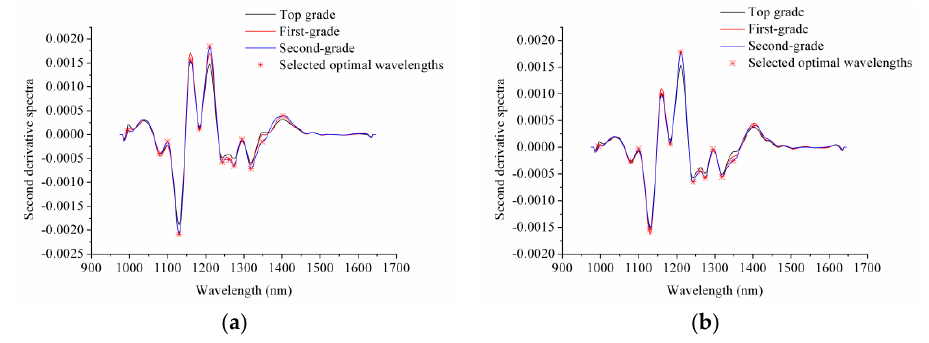
Figure 5. Optimal wavelengths selected by second derivative spectra of ( a ) intact sausages and ( b ) sliced sausages. Table 2. Selected optimal wavelengths by second derivative spectra and RF for intact sausages and sliced